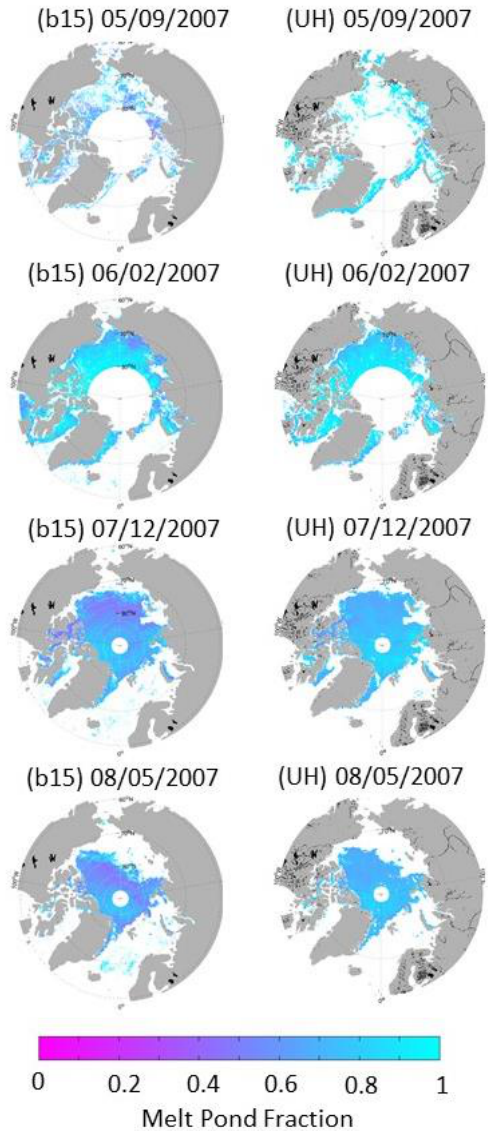
Figure 6 Comparison between MPF from B15 algorithm and that from University